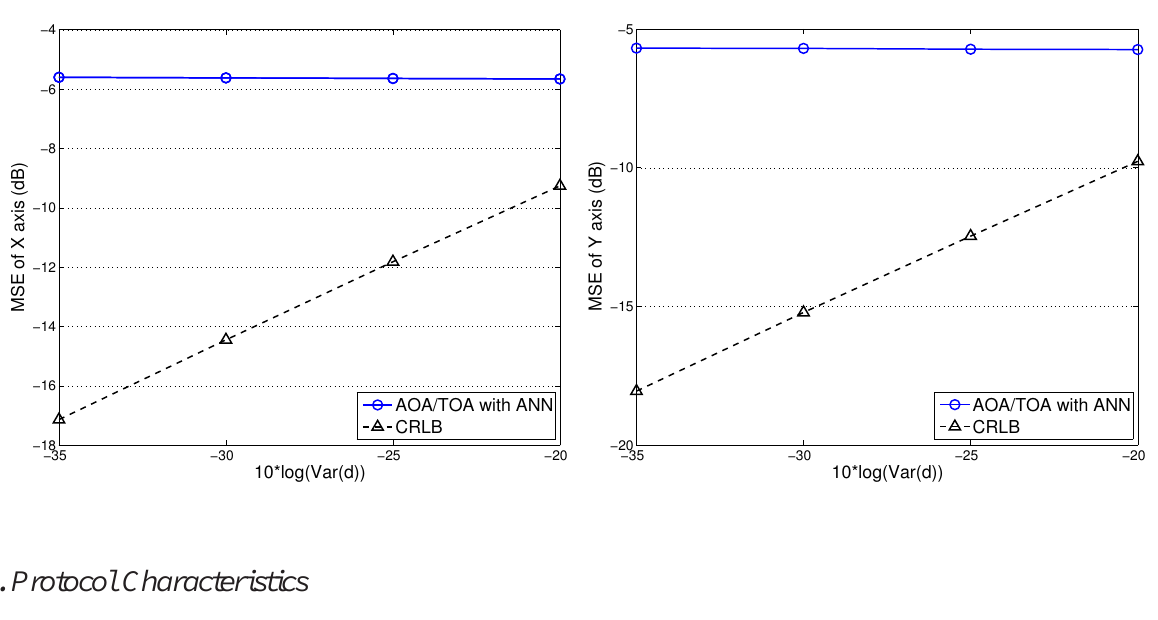
Figure 15. The performance comparison of TCAT with joint AOA/TOA and CRLB: X-axis ( left ) and Y-axis ( right